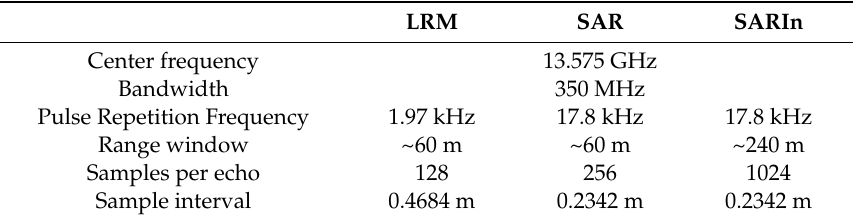
Table 1. Specifications of the CS-2